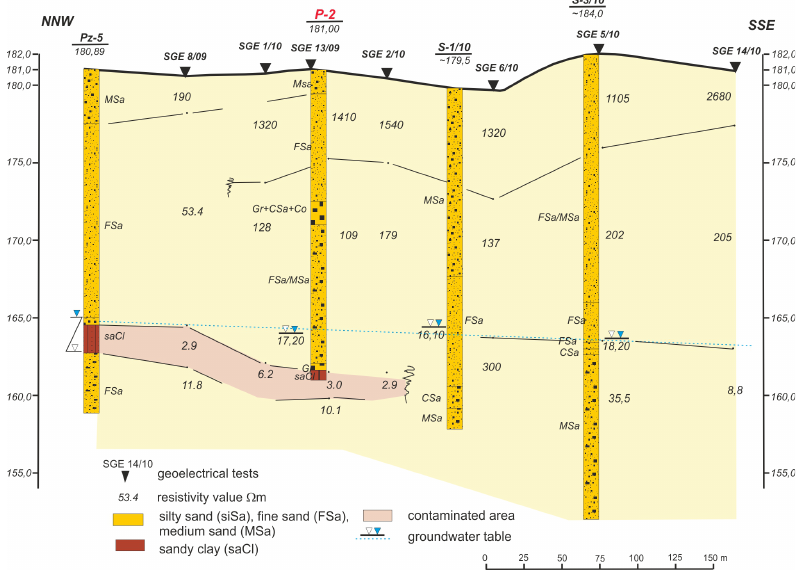
Figure 4. Geoelectrical cross-section of the landfill subsoil.